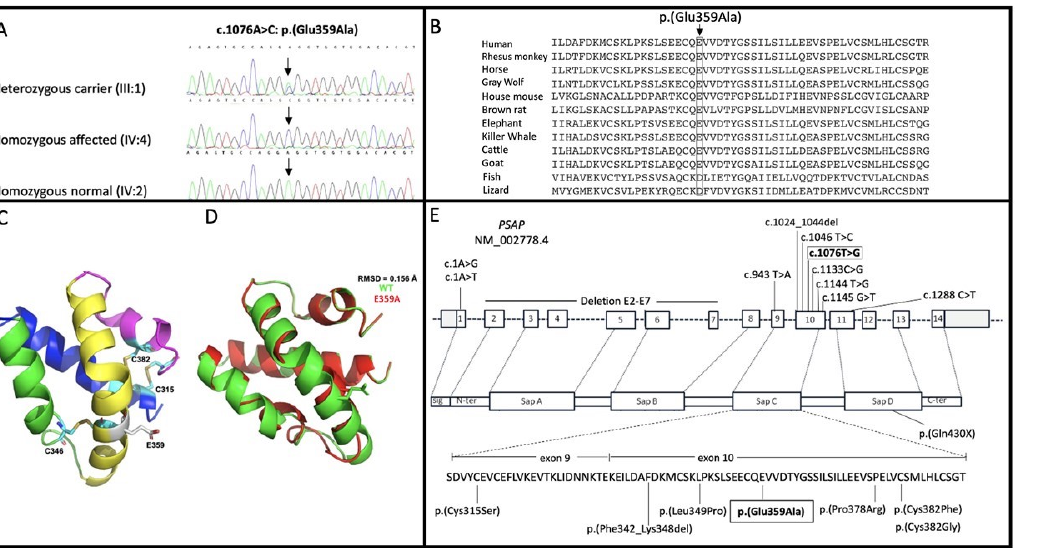
Figure 2. Overview of PSAP (NM_002778.4) protein domains, sequence data on variant c.1076A>C, p.(Glu359Ala) in family DEM4599 and a predicted three-dimensional structure of Sap-C. ( A ) Chro- matograms showing likely pathogenic missense variant c.1076A>C, p.(Glu359Ala) in the PSAP in heterozygous unaffected carrier (III:1) (upper panel), homozygous affected family member (IV:4) (middle panel), and homozygous wild-type unaffected family member individual (IV:2) (bottom panel). ( B ) The mutated amino acid residue Glu359 located in the Sap-C domain is conserved among various species analyzed. ( C ) Three-dimensional structure of the wild-type Sap-C domain in ribbon representation with the conserved cysteine residues are indicated. ( D ) The superposed structure of wild (green color) and mutant (red color) structure showing the difference in overall confirmation due to the p.E359A mutation. RMSD (root mean square deviation). ( E ) Structure of PSAP